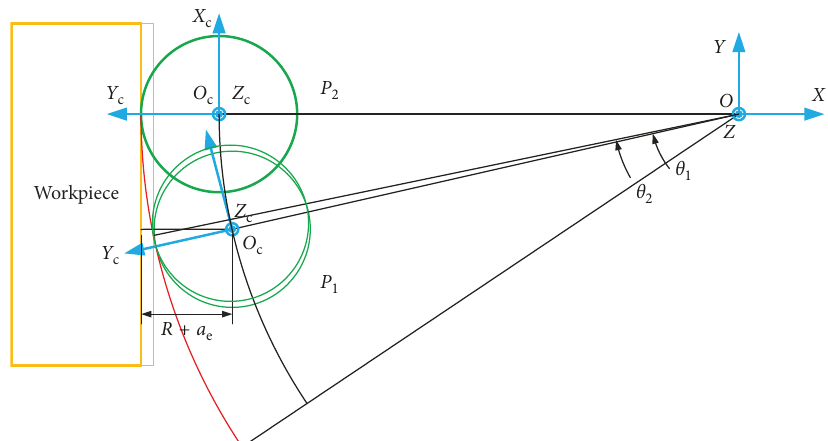
Figure 10: Different stages for the cutter entering workpiece along a circular path.